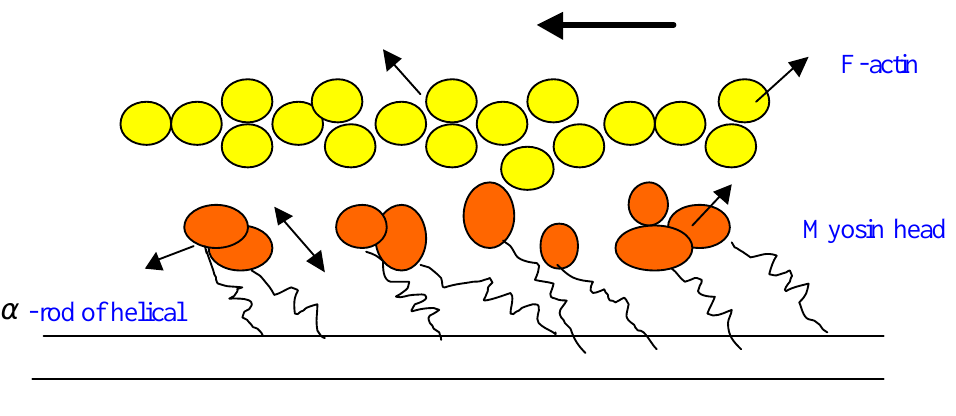
Figure 1. The imaging of the actin-moysin